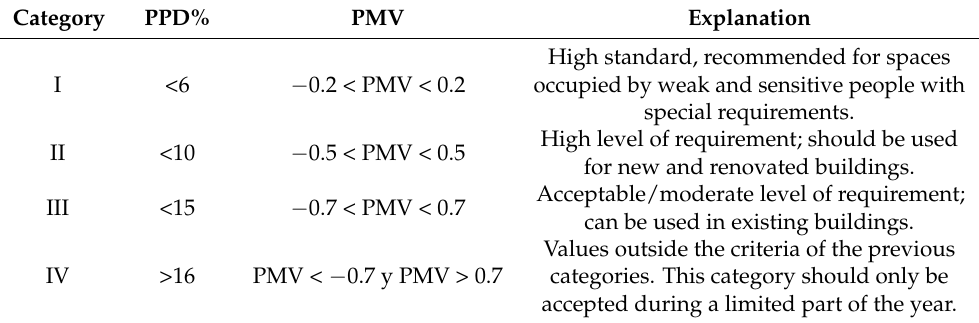
Table 1. Thermal comfort categories